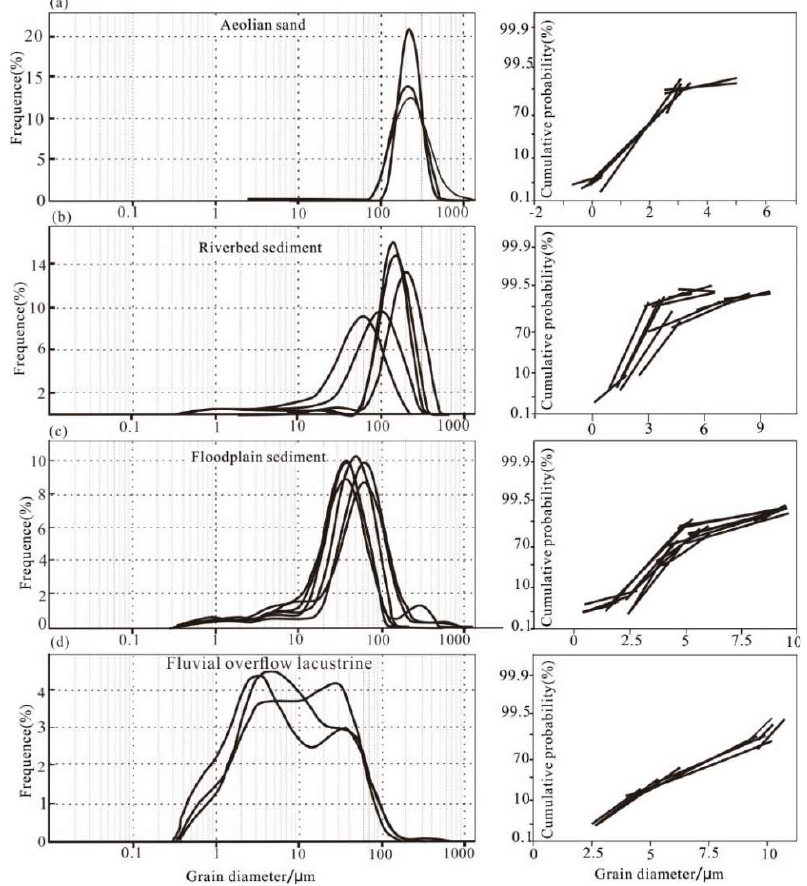
Figure 5. Grain-size distributions and Probability cumulative curves of sediments from different sedimentary environments. ( a ) GSDs of aeolian sand. ( b ) GSDs of riverbed sediments. ( c ) GSDs of sediments from floodplain environment. ( d ) GSDs of sediments from fluvial overflow environ- ment.